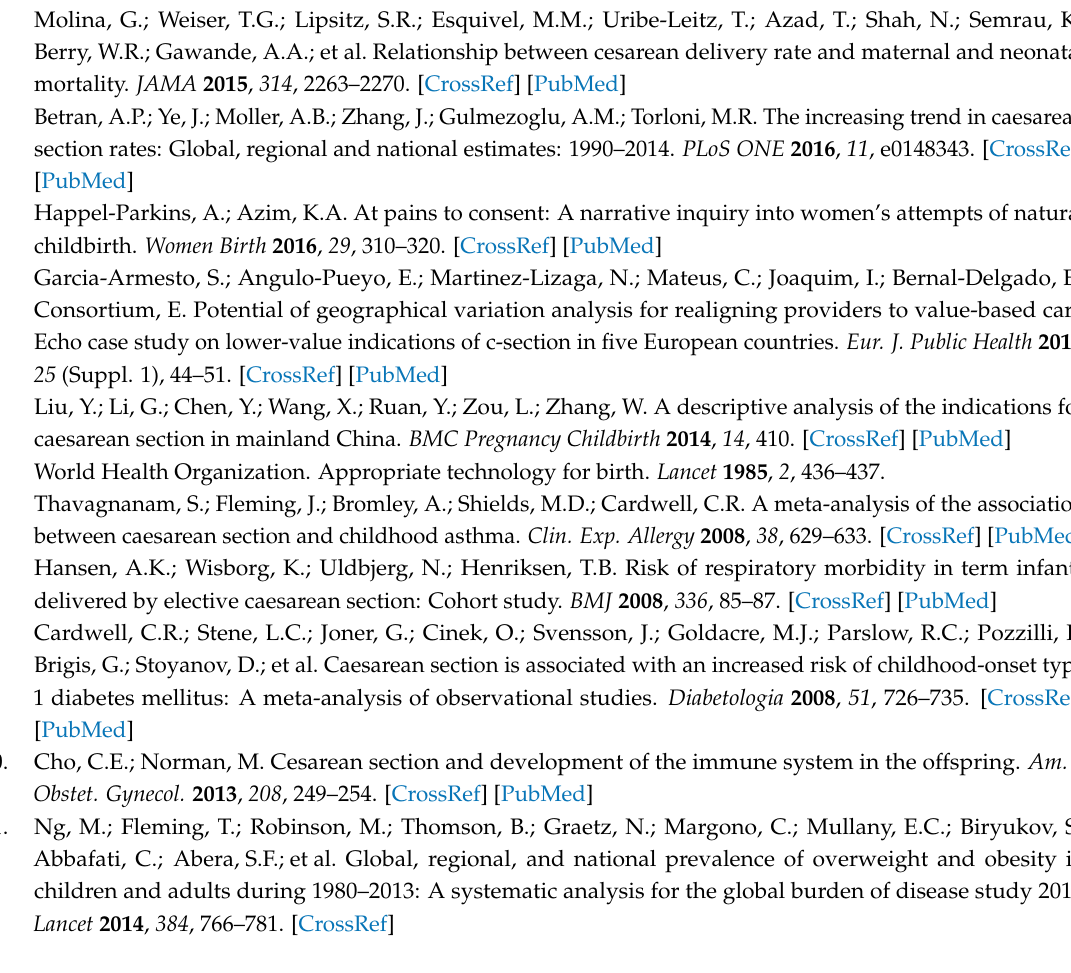
Figure S1: Directed acyclic graph (DAG) illustrating relationship of delivery mode and overweight/obesity and confounders, Table S1: Lifestyle of children and adolescents by different mode of delivery; Table S2: Crude and multivariable adjusted risk ratios for obesity in offspring associated with cesarean vs. vaginal delivery; Table S3: Differences of BMI z-scores between cesarean and vaginal delivery (means ±